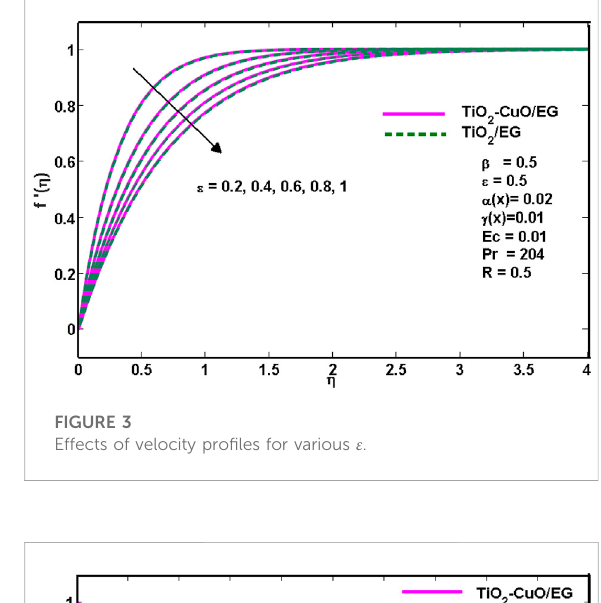
FIGURE 3 Effects of velocity pro fi les for various ε .